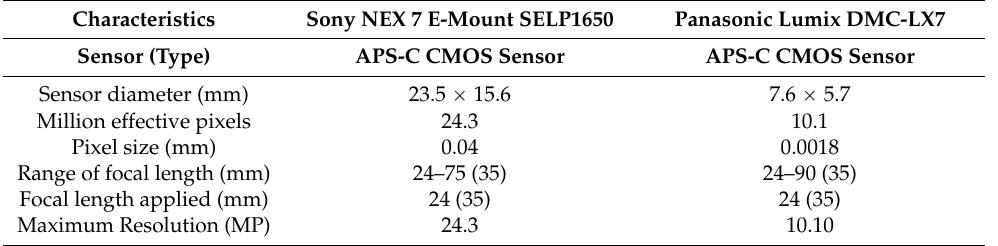
Table 2. Key characteristics of the cameras used to collect the aerial imagery for each of the resolutions compared. The Sony NEX 7 E-mount SELP1650 was used to collect the imagery at 2.5 cm and 5 cm resolution. The Panasonic Lumix DMC-LX7 was used to obtain the imagery at 10 cm